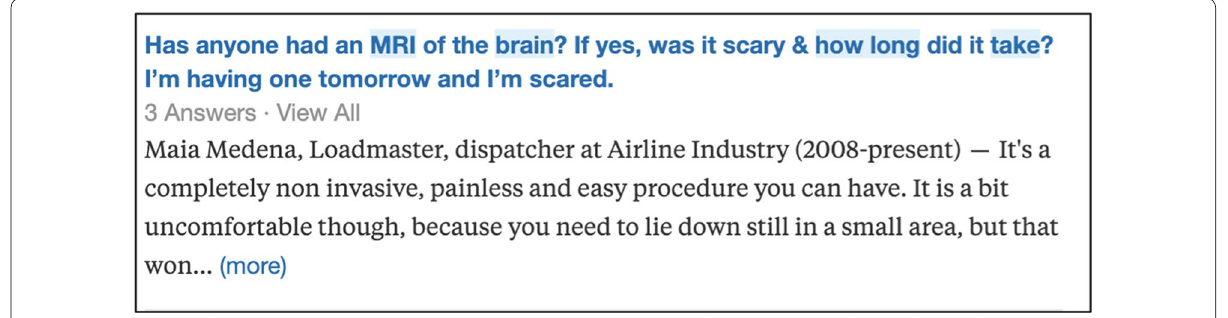
Fig. 1 An example of a question from